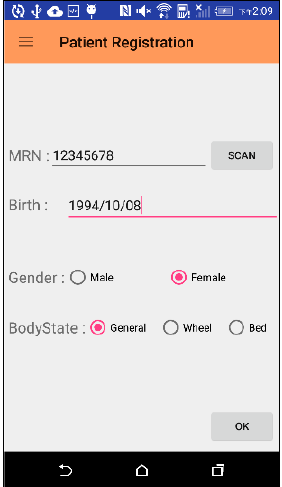
Figure 12. Operation screen of patient check-in